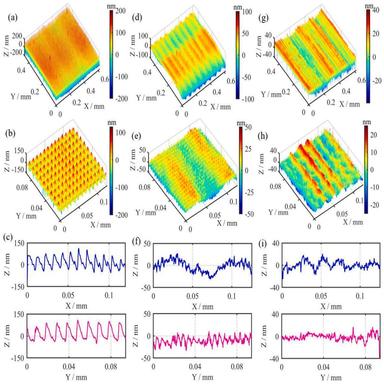
Surface topographies at the machining conditions of with different measurement magnifications: I - (a) 10 × and (b) 50 × with (c) profiles, II - (d) 10 × and (e) 50 × with (f) profiles, and III - (g) 10 × and (h) 50 × with (i) profiles.